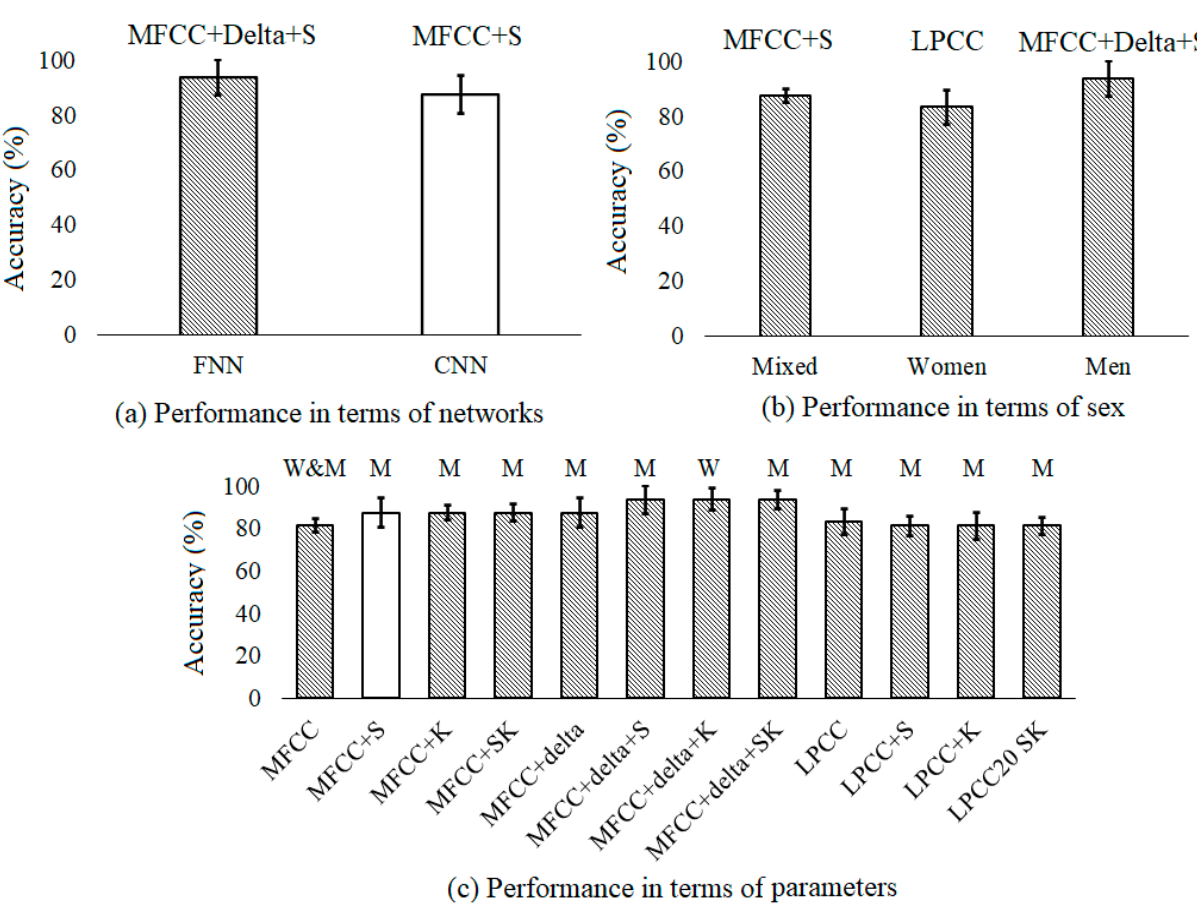
Figure 5. Comparison of performances in terms of networks, gender, and various parameters (S: skewness; K: kurtosis; SK: skewness and kurtosis; W&M: mixed female and male data; M: male data; W: female data). Gray bars indicate FNN.